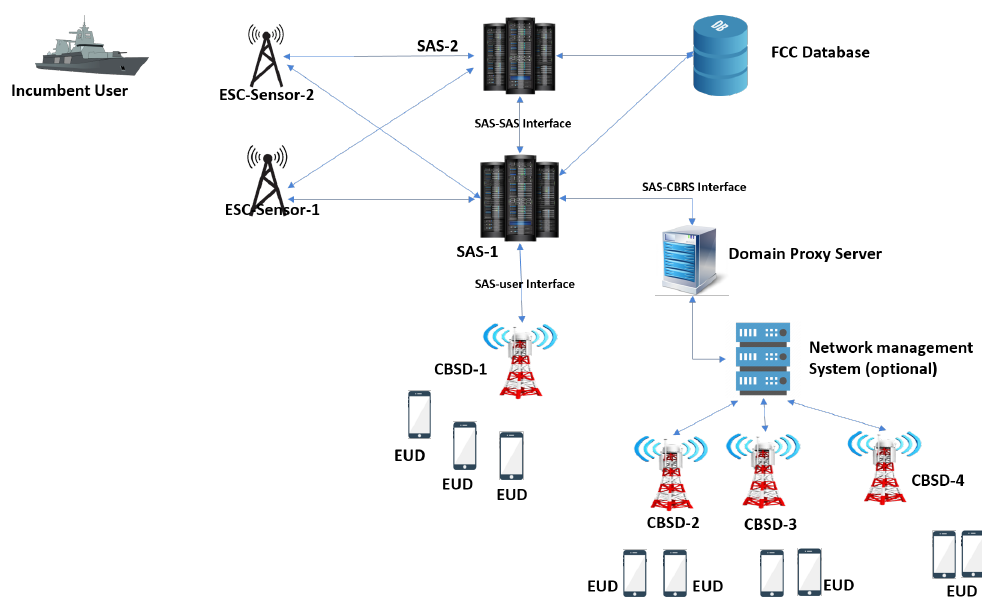
Figure 2. CBRS-SAS